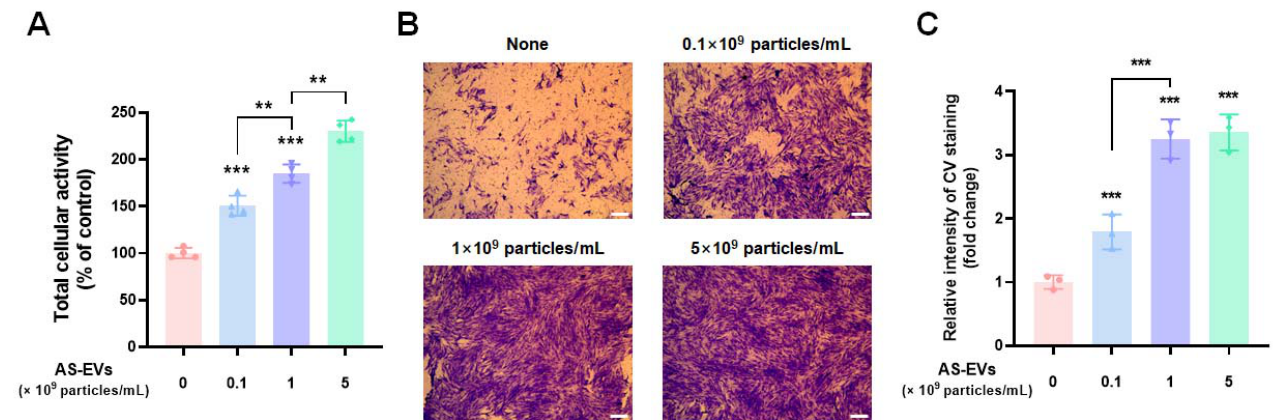
Figure 4. Effect of AS ‐ EVs on the proliferation and migration of HDFs. ( A ) After serum starvation, HDFs were treated with AS ‐ EVs for 48 h in serum ‐ free DMEM/F12. The population of viable cells was evaluated by WST ‐ 8 assay. Statistical significance was determined by comparison with the control group not treated with AS ‐ EVs if not indicated (** p < 0.01, *** p < 0.005, n = 4). ( B ) Migration of HDFs treated with AS ‐ EVs was evaluated by transwell migration assay. After 24 h treatment with AS ‐ EVs, the HDFs that had migrated to the bottom side of the porous membrane were stained with CV and followed by fixation with 4% PFA. Scale bar indicates 200 μ m. ( C ) For quantitative analysis, the stained membrane was cut out and immersed in a 50% acetic acid solution to dissolve the crystalized CV. The intensity of CV staining was determined as optical absorbance at 560 nm. Statistical significance was determined by comparison with the control group not treated with AS ‐ EVs (*** p < 0.005, n = 3).